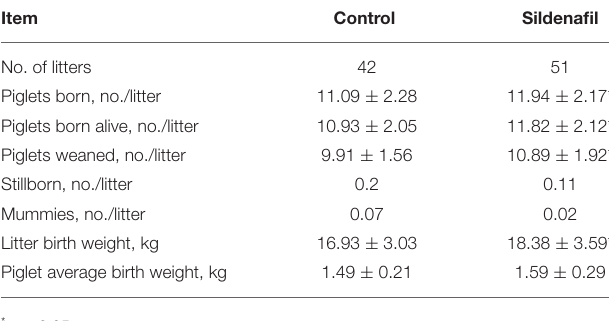
TABLE 5 | Effect of sildenafil intervention from day 30 to 110 of gestation on sow litter performance (means ± SD).